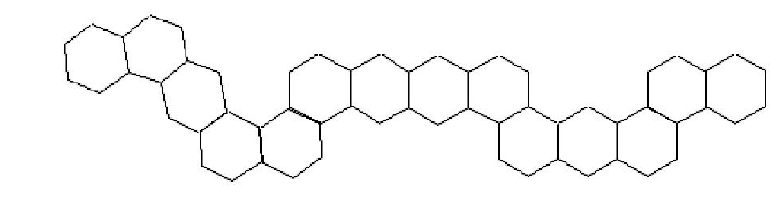
Figure 1: The Molecular Graph of a Benzenoid Chain BC (2, 3, 2, 2, 4, 2, 3, 2, 2)